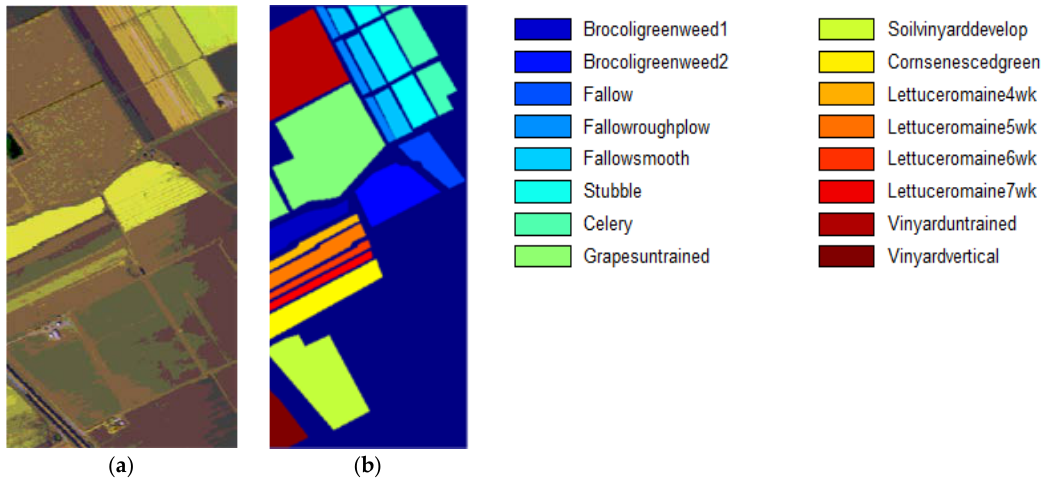
Figure 2. Salinas dataset. ( a ) False color composition; ( b ) Ground-truth.